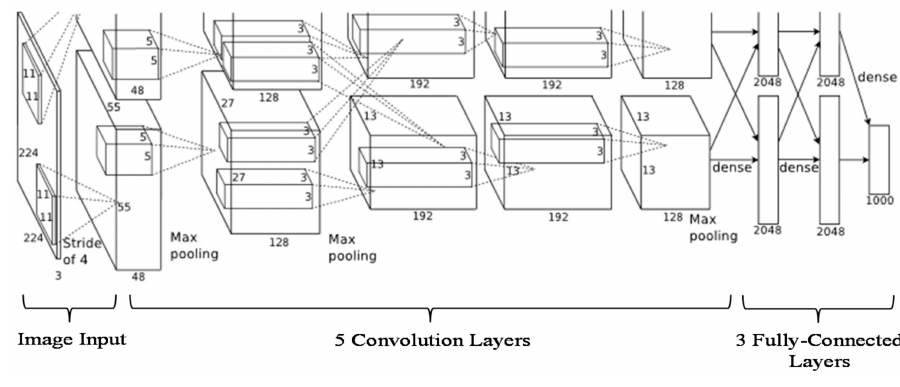
Figure 5. AlexNet Architecture.